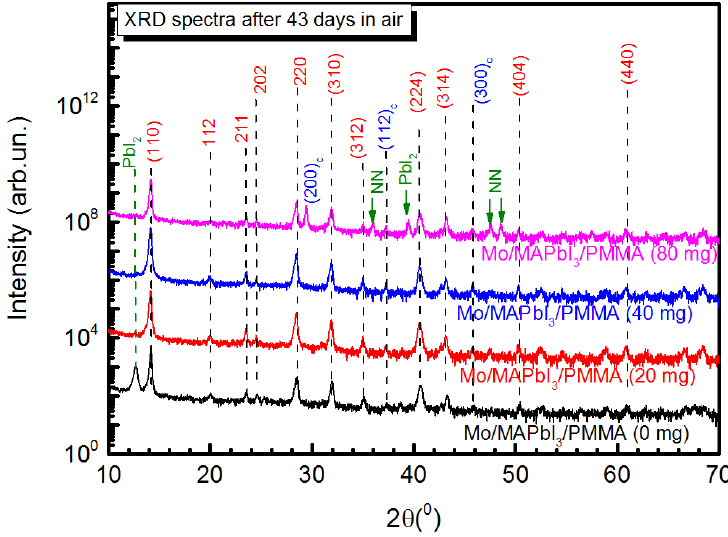
Figure 4 . Grazing incidence X ‐ ray diffraction patterns of Mo/perovskite coated with PMMA at concentrations of 0, 20, 40, and 80 mg/mL (black, red, blue, and magenta) after 43 days of storage in air.